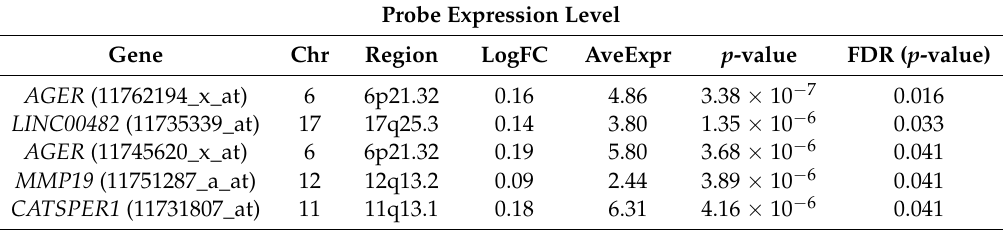
Table 1. DEA statistical results for probes gene level and DEA for the mean of probe set expression level for early mild cognitive impairment (EMCI) versus late mild cognitive impairment (LMCI). Chr: chromosome; LogFC: log2-fold-change; AveExpr: average expression; T: Student’s t-test value; FDR: false discovery